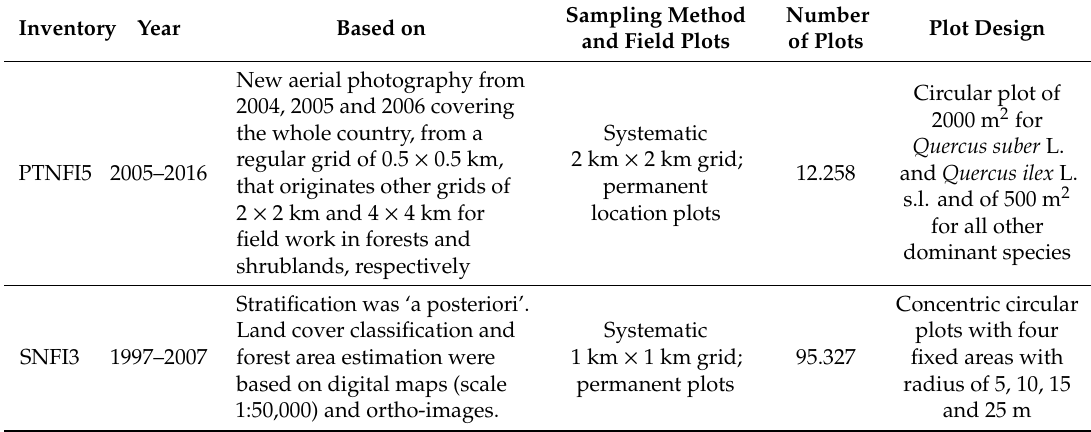
Table 1. Overview about the sampling methods applied by the National Forest Inventory in Portugal and Spain